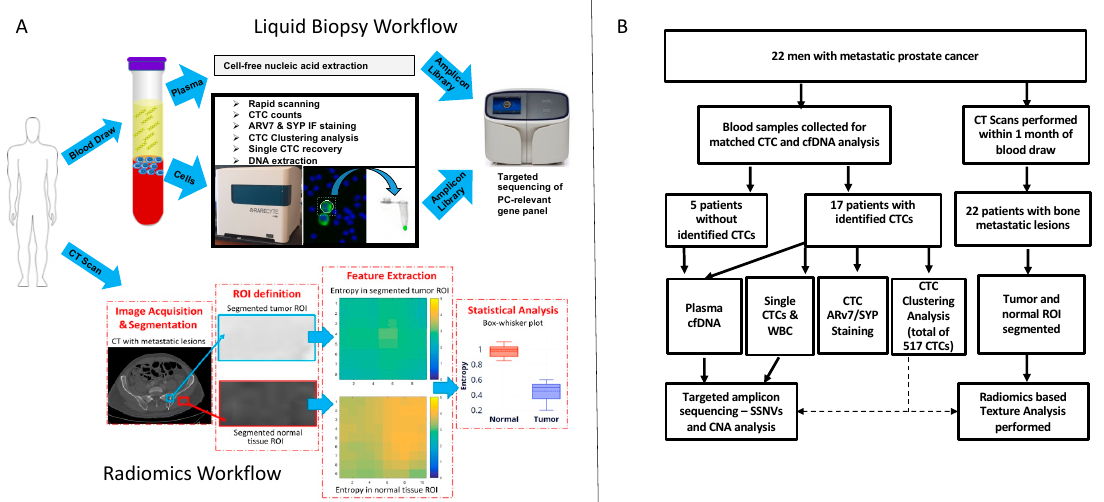
Figure 1. Multiparametric liquid biopsy workflow. A . Peripheral blood is drawn and delivered onsite to the Liquid Biopsy Core, where it is separated into plasma and mononuclear cell components. Cell-free nucleic acid is extracted from plasma. CTCs and WBCs are identified using immunofluorescent staining and automated high content imaging. Single cells are recovered for DNA extraction. Plasma and single cell derived nucleic acids are used to generate amplicon libraries for targeted sequencing of PC-relevant genes. Matched CT scans undergo image segmentation, region of interest (ROI) definition, feature extraction, and statistical analysis. B . Consort diagram outlining patients, samples, and workflows performed in this study.